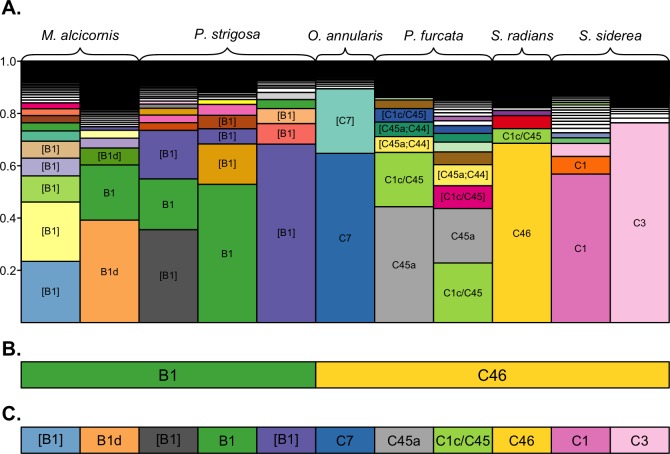
OTU assignments by different clustering approaches.Comparison of dominant OTUs assigned by 100%, 97% across-sample, and 97% within-sample clustering approaches. (A) The composition of unique sequence variants (i.e., 100% OTUs) in each sample, sorted by relative abundance, and filled by unique colors corresponding to unique sequence variants. Sequence variants are annotated with the name of their best-matching reference sequence, with brackets indicating the match is not exact (only OTUs with a relative abundance >0.05 are annotated for clarity). The dominant OTUs within each sample assigned by (B) 97% across-sample clustering and (C) 97% within-sample clustering are shown by rectangles below each bar, with fill colors matching the unique sequence variants presented in (A) to indicate the representative sequence of the assigned OTU. Colored rectangles that span multiple bars indicate that the corresponding samples were assigned the same dominant OTU.